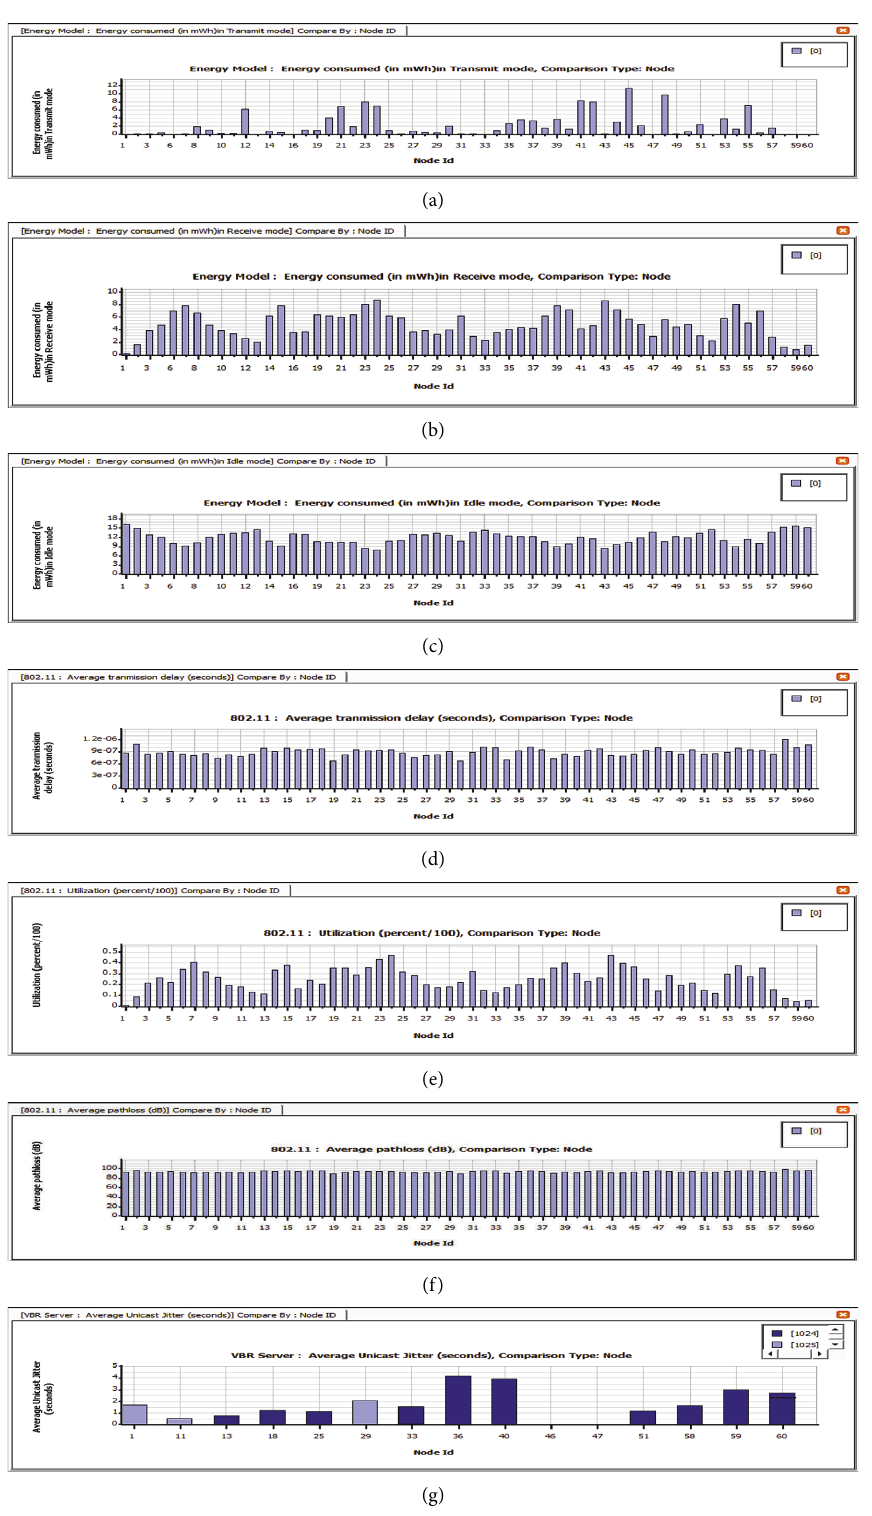
Figure 21: (a) Transmit mode energy consumption of LAR1 for VBR deployment. (b) Receive mode energy consumption of LAR1 for VBR deployment. (c) Idle mode energy consumption of LAR1 for VBR deployment. (d) Average transmission delay of LAR1 for VBR de- ployment. (e) Percentage of utilization of LAR1 for VBR deployment. (f) Average pathloss of LAR1 for VBR deployment. (g) Average jitter of LAR1 for VBR